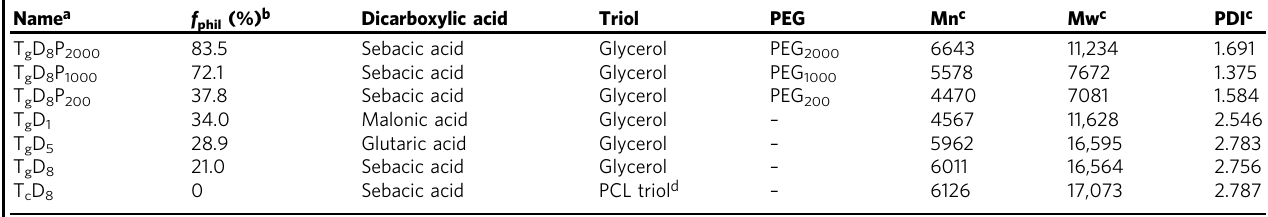
Table 1 Characterization of TDP polymers